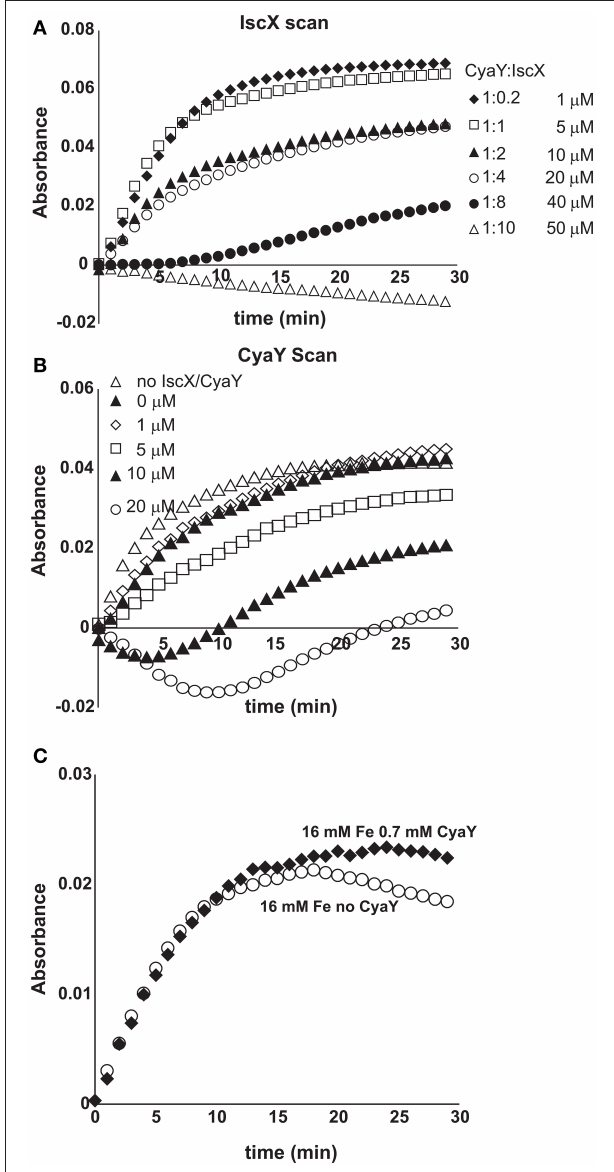
FIGURE 6 | Competition between IscX and CyaY. (A) Assay carried out using 25 µ M Fe 2 + in the co-presence of CyaY (5 µ M) and increasing concentrations of IscX in the range 0–50 µ M. When both CyaY and IscX are present, there is a competition which, under otherwise the same conditions, depends on the IscX:CyaY ratios. (B) As in (A) but with the concentration of IscX fixed to 5 µ M and various concentrations of CyaY. (C) Enzyme kinetics carried out with concentration ratios similar to those observed in the cell (4.1 µ M IscS, 250 µ M Cys, 2mM DTT, 1.0 µ M IscX, 0.7 µ M CyaY, and 25 µ M Fe 2 + ).